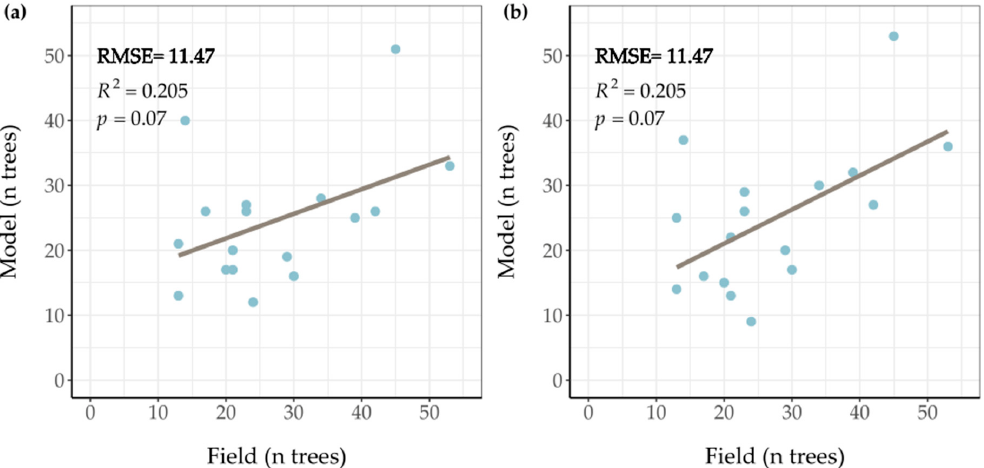
Figure A2. The general habitat appearance and foliage of the four gymnosperm tree species used in the analysis with ( a ) Japanese larch ( Larix kaempferi ), ( b ) Norway spruce ( Picea abies ), ( c ) Scots pine ( Pinus sylvestris ), and ( d ) Douglas fir ( Pseudotsuga menziesii ). All photographs were made by the authors.